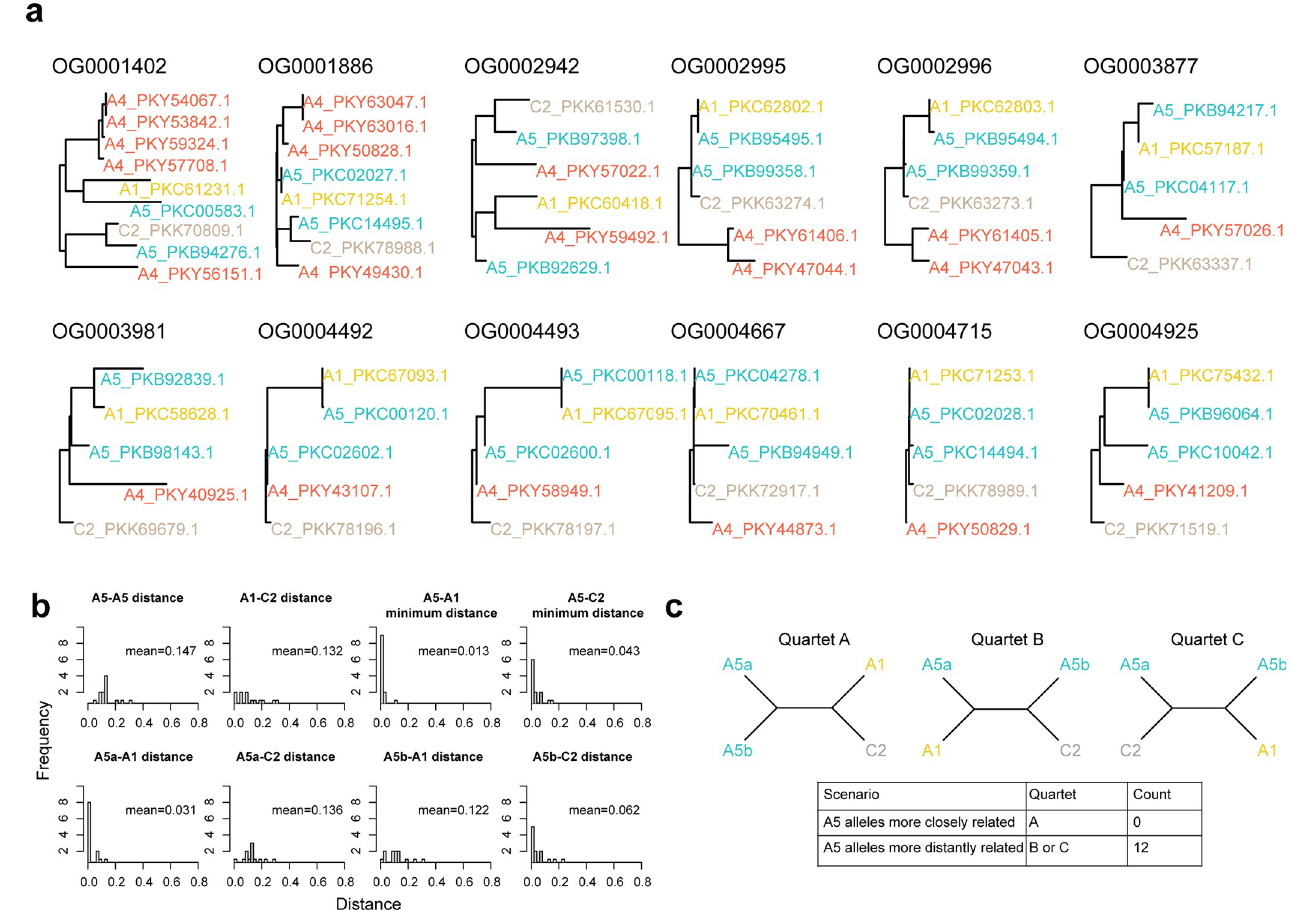
Fig 4. Nuclei from isolate A5 share a more recent evolutionary origin to isolates A1 and C2 than among them. a, Phylogenetic reconstruction of nucleotype-specific alleles in isolate A5 and its orthologs in isolates A1, C2 and A4. c, Average genetic distances between the different nucleotype-specific alleles from two alleles from isolates A5 and their homologs in isolates A1 and C2. We show histograms representing the genetic distance between the two nucleotype- specific alleles of isolate A5 and their homologues in isolates A1 and C2. For comparisons between A5 and C1 or A1 we used the minimum distance of the two alleles from A5. d , Scenarios of genetic similarity between the two A5 alleles and alleles from A1 and